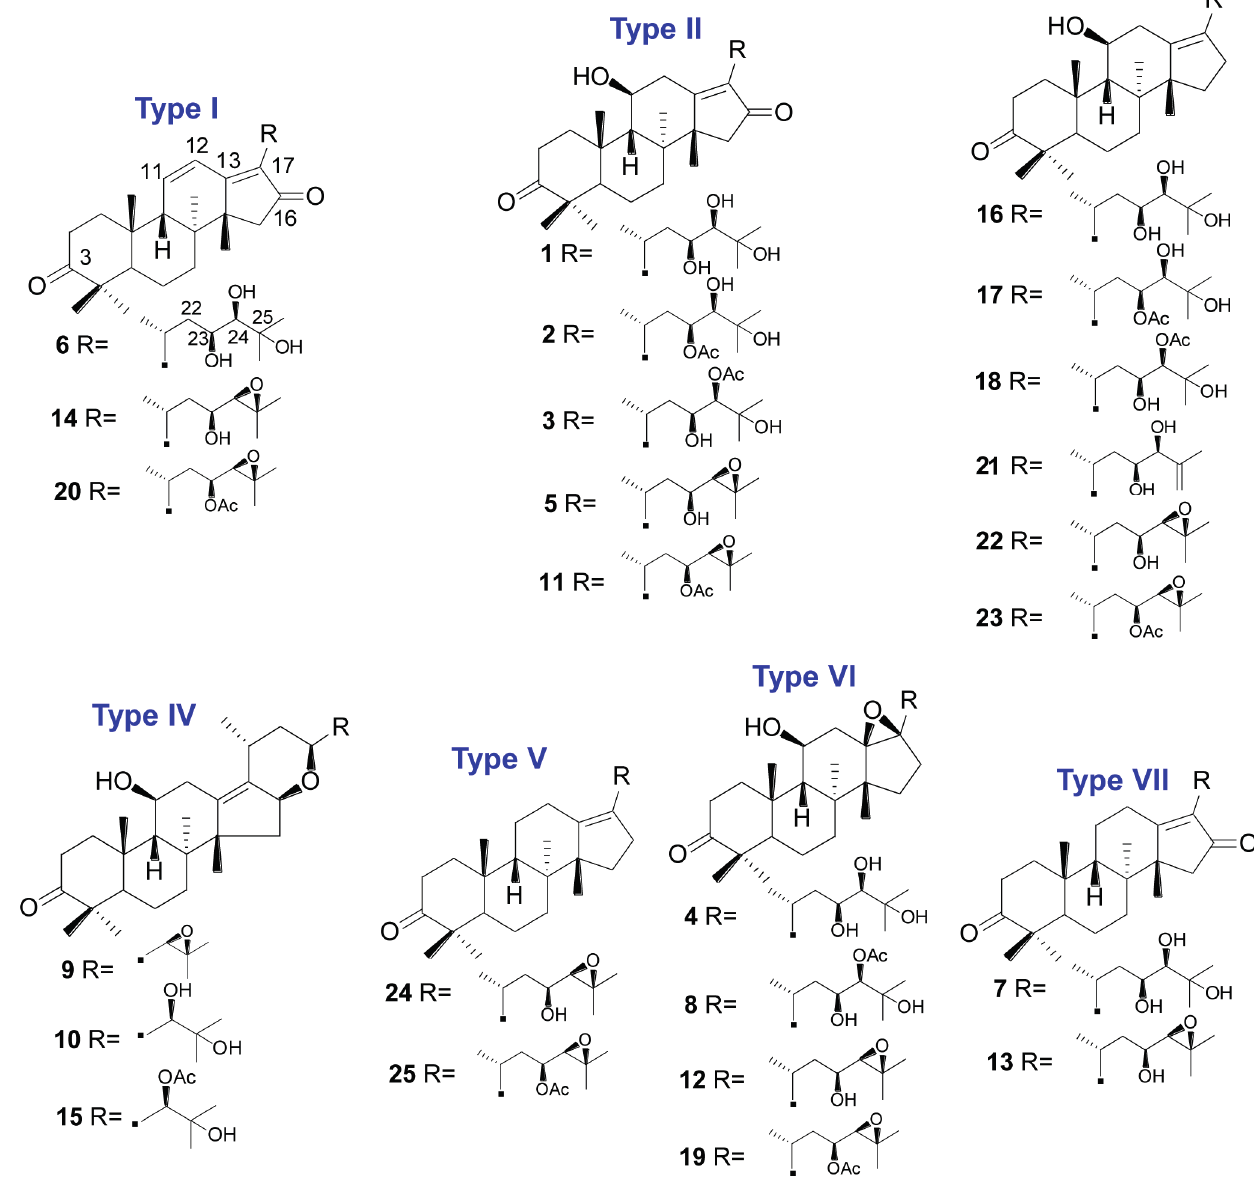
Figure 1. Chemical structures of the identi fi ed triterpenoids from